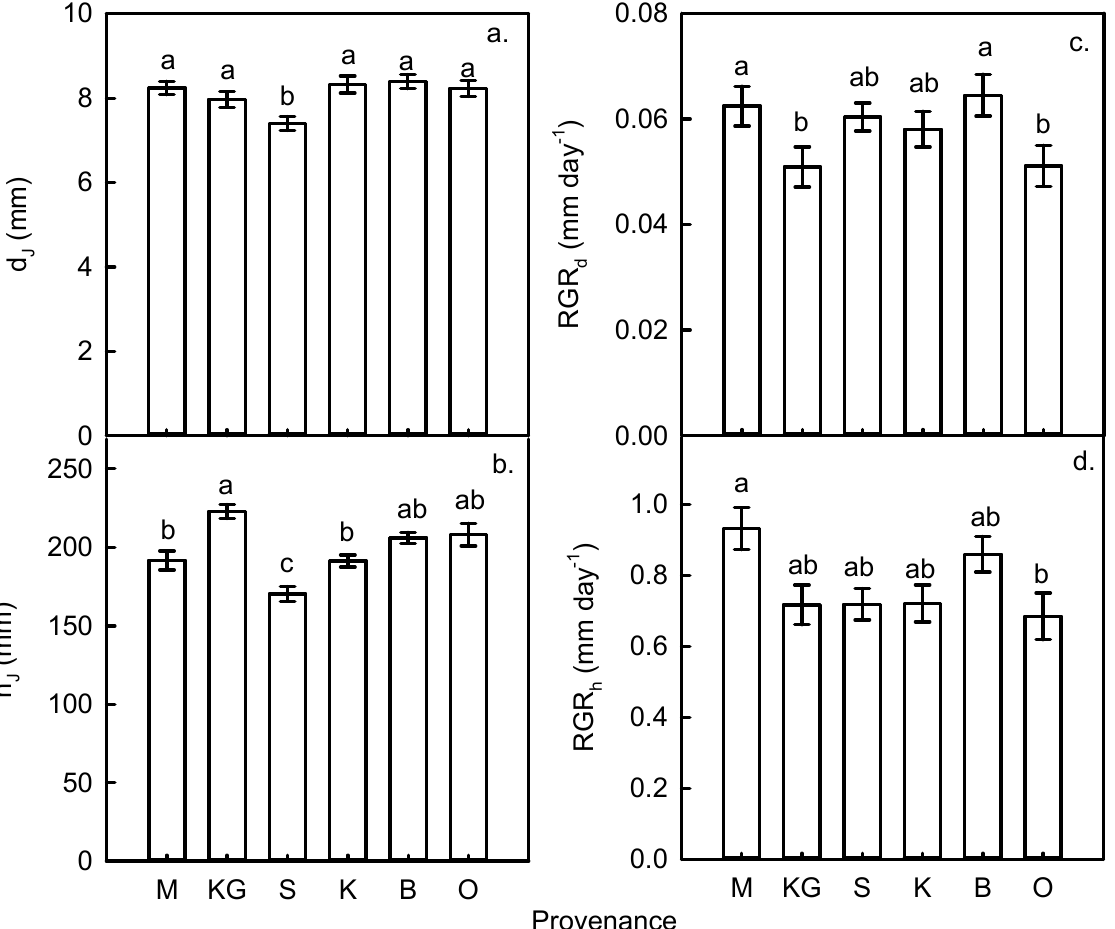
Figure 1. Growth parameters of Abies alba seedlings from six northern provenances measured in June 2019 (means ± SE). ( a ) Diameter at root collar in June ( d J ); ( b ) height of seedlings in June ( h J ); ( c ) relative growth rate at root collar ( RGR d ); ( d ) relative growth rate of height ( RGR h ). The results of ANOVA are shown in Table 3. The same letters above columns indicate that the mean values are not different using Tukey’s test at p < 0.05 ( n = 40, n —number of seedlings per provenance). M − “Mi ę dzylesie”, KG—“Kamienna Góra”, S—“Syców”, K − “Kolumna”, B—“Brzeziny”, O— “Osusznica”.